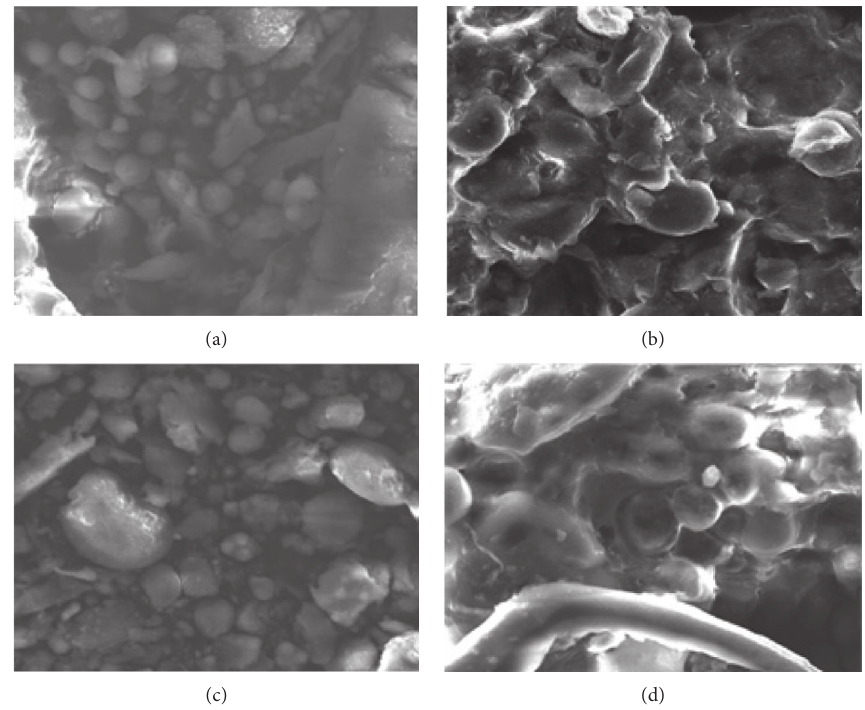
Figure 1: SEM of samples showing starch granules and proteins of emmer varieties: (a) Hydroo, (b) local landrace, (c) Lameso, and (d) Sinan